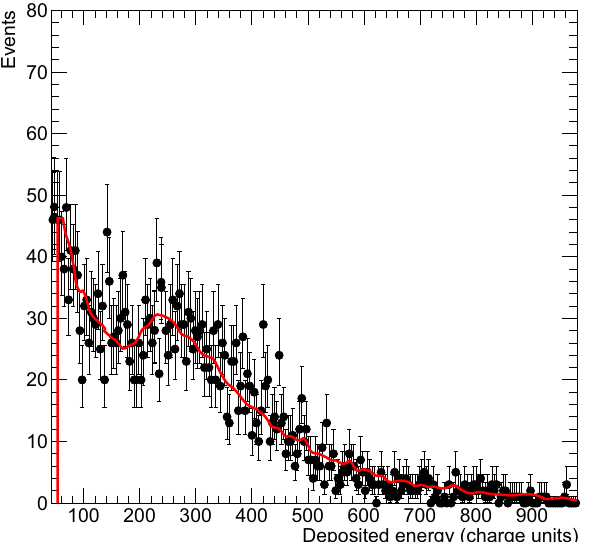
Fig. 16 Measured energy distribution for a single ECal crystal, in charge units, for cosmic-rays events selected according to the algo- rithm described in the text. The red curve represents the result of the fit performed using the template shape obtained from Monte Carlo simu-